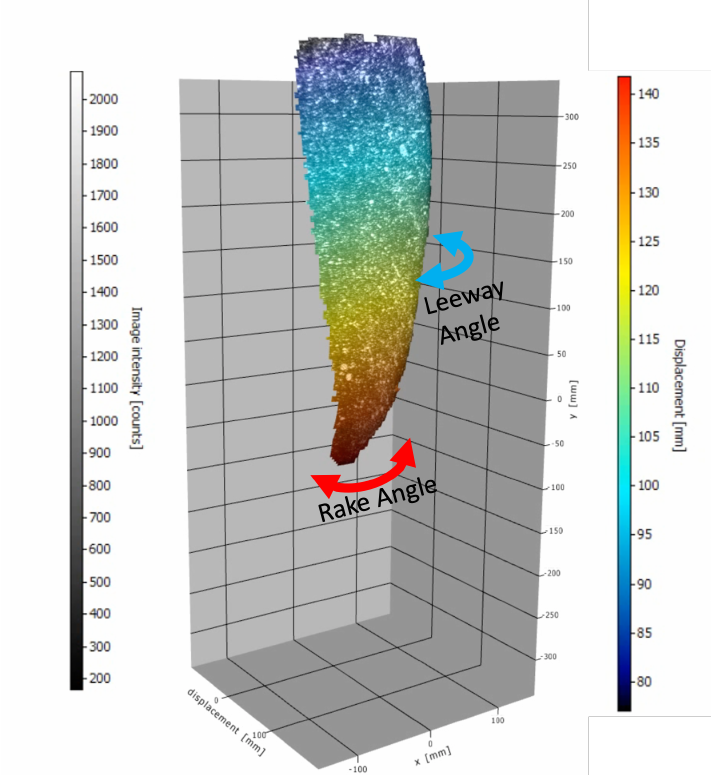
Figure 12. NACRA 17 Z-Foil tip section deflection as measured from the stereo-DIC configuration. The rainbow color-map specifies the displacement magnitude. The gray-scale color-map specifies the intensity counts of the randomized speckles applied with paint on the surface of the Z-Foil as seen from the DIC